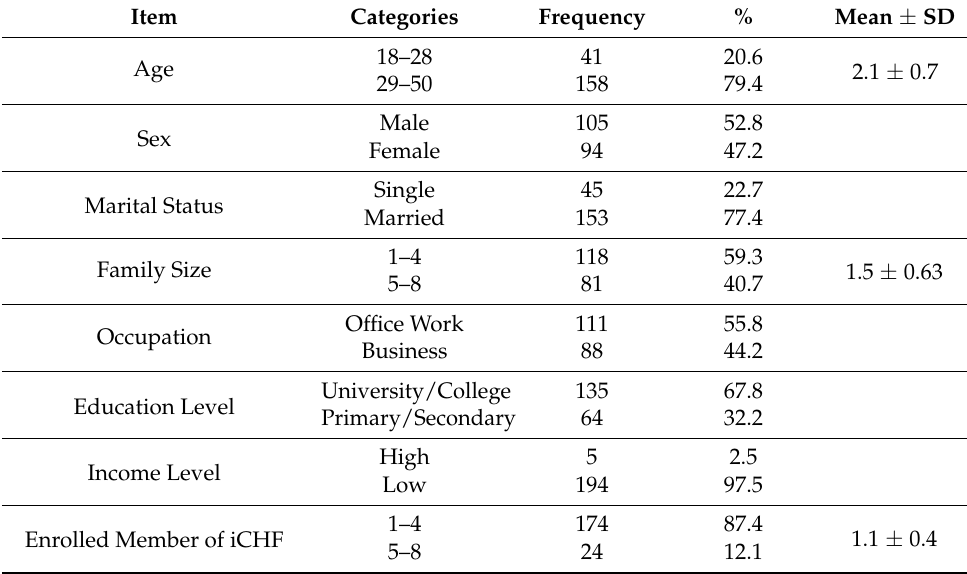
Table 2. Sociodemographic characteristics of community